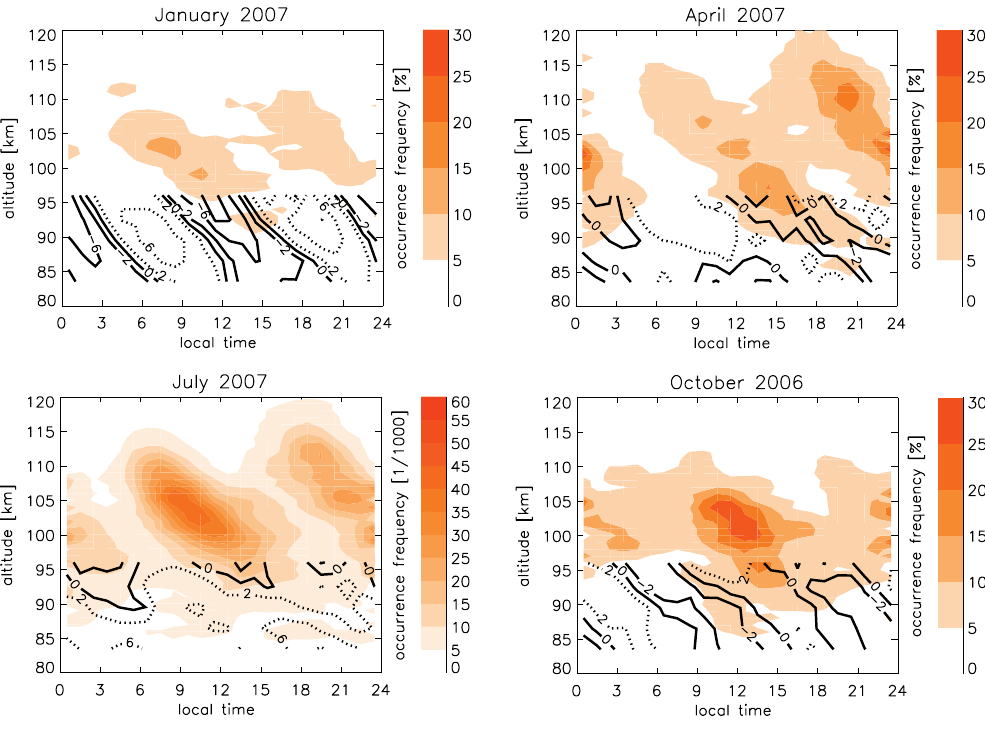
Fig. 5. CHAMP, GRACE and FORMOSAT-3/COSMIC relative E s layer occurrence (in 1/1000), for a latitude range from 50 ◦ –55 ◦ N (redscaling). In the lower part monthly mean wind shears are shown as isolines, given in ms − 1 km − 1 , measured with the Collm meteor radar. Negative shear values are marked with solid isolines. Note the different scaling for summer E s